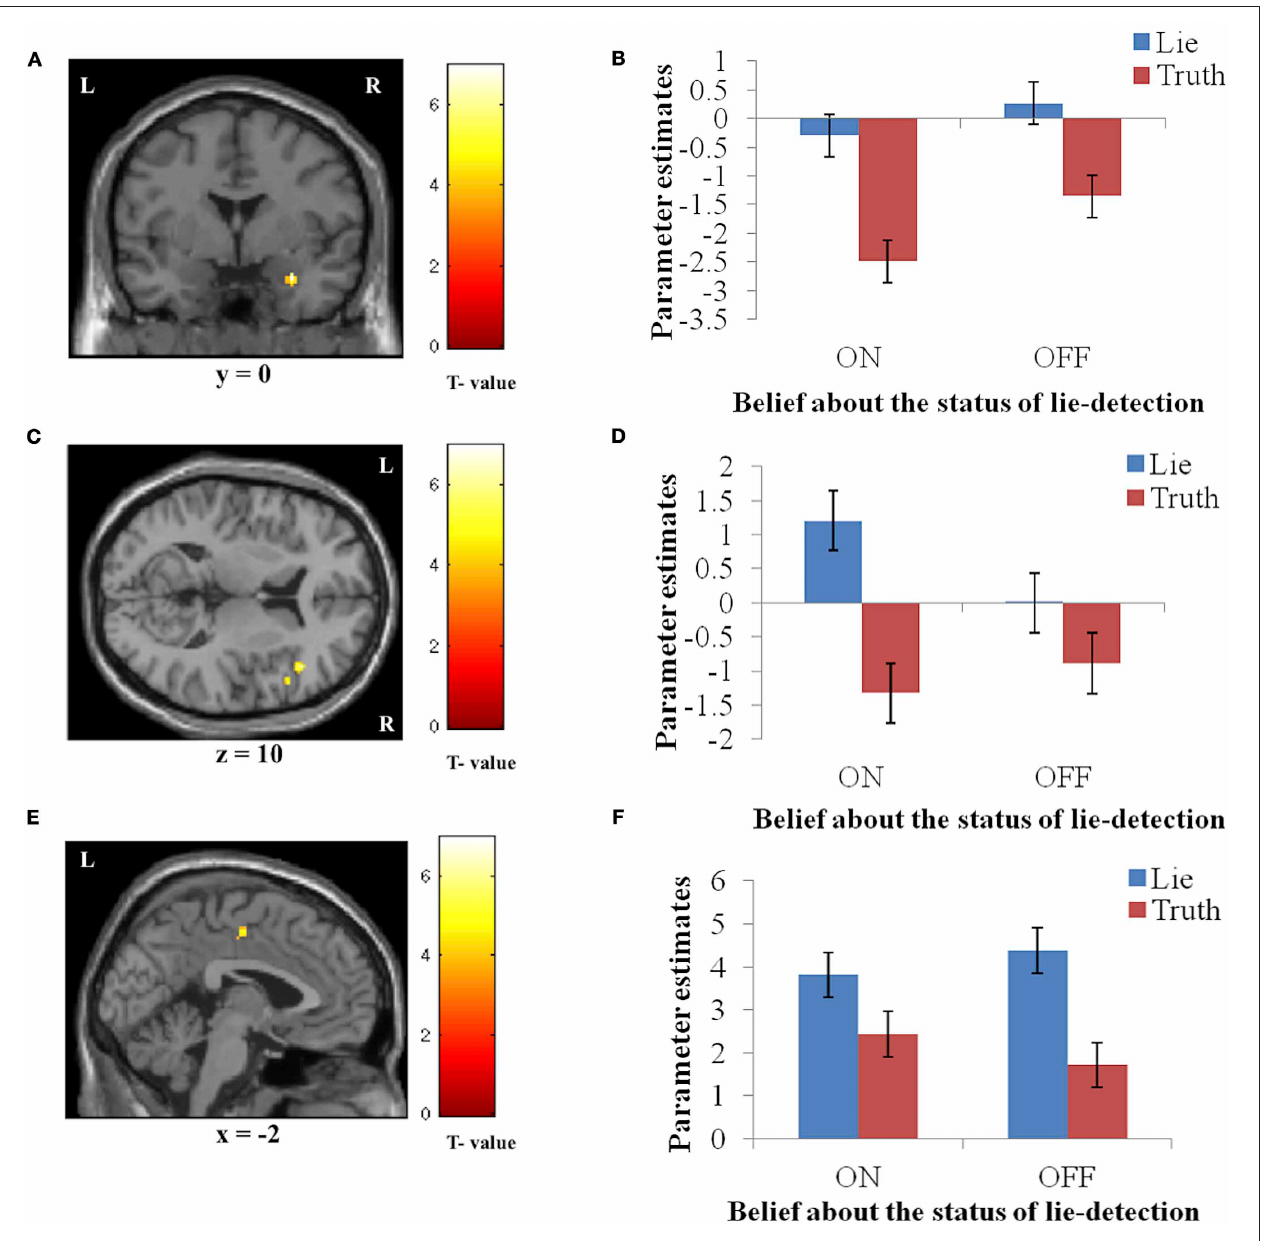
FIGURE 3 | The main effect of response (false > true). Panels on the left show the activation cluster and panels on the right show mean parameter estimates in the activation cluster in the right amygdala ( A and B ), right IFG